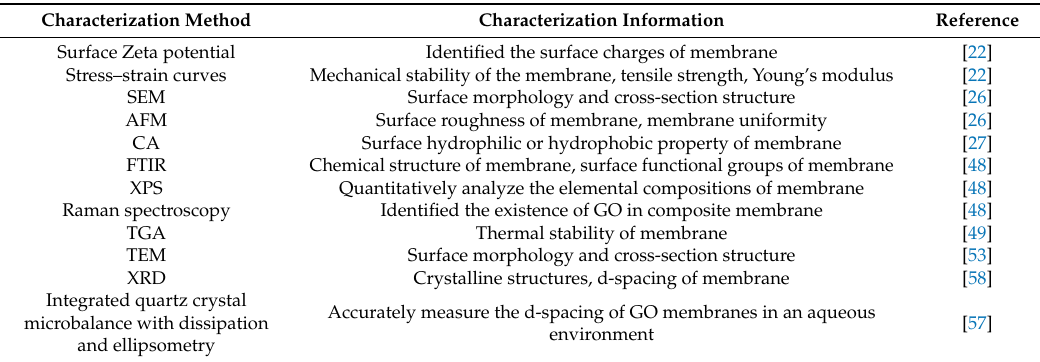
Table 4. Methods for the characterization of GO